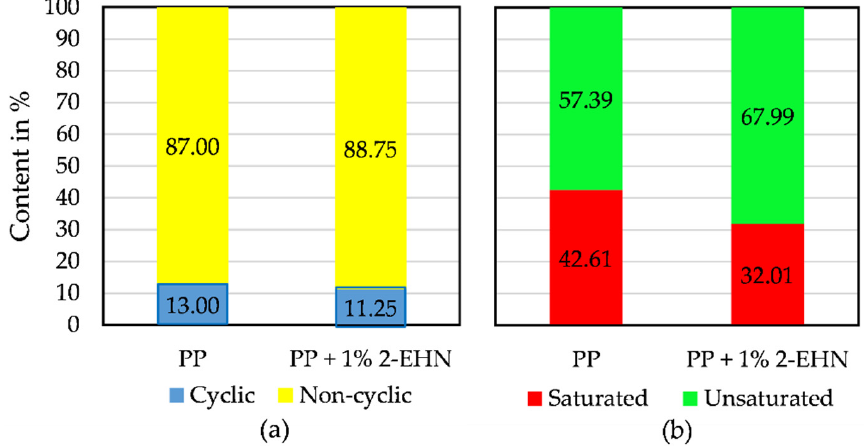
Figure 4. Content of ( a ) cyclic (blue) and non ‐ cyclic (yellow) compounds and ( b ) the content of sat ‐ urated (red) and unsaturated (green) compounds each in % of PP and PP + 1% 2 ‐ EHN pyrolysis oils. rated (red) and unsaturated (green) compounds each in % of PP and PP + 1% 2-EHN pyrolysis